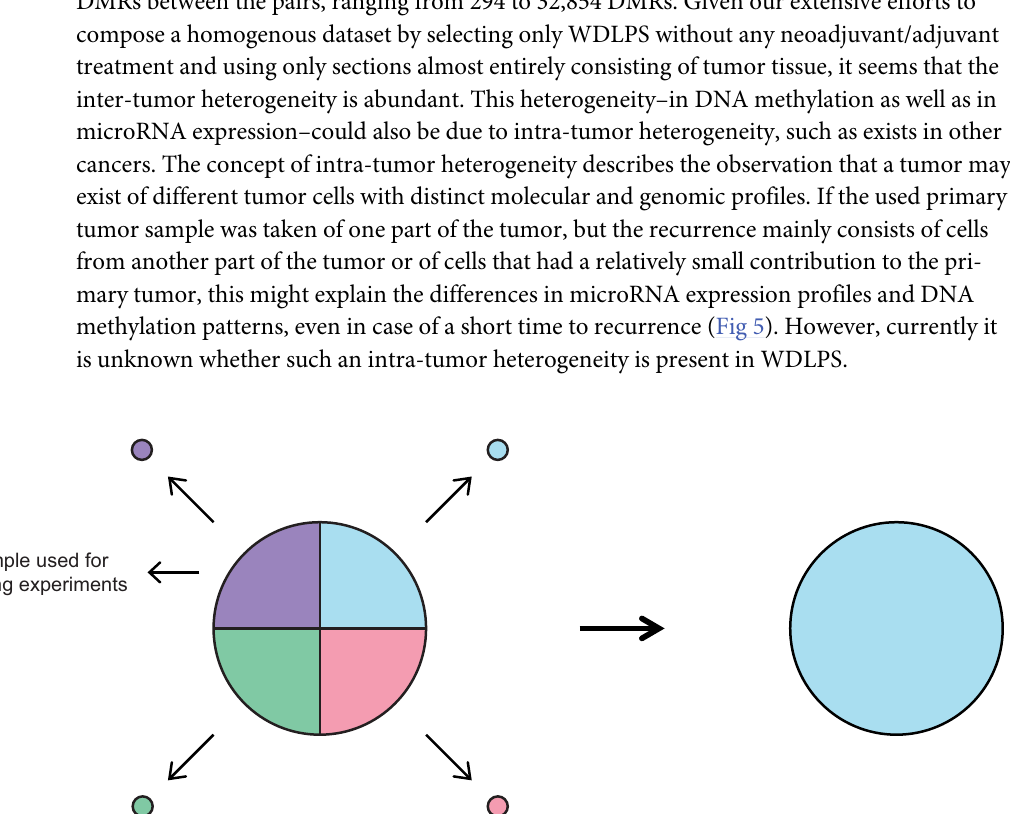
Fig 4. Hierarchical clustering based on differentially methylated DNA regions (DMRs) between paired WDLPS tumor samples for the two main localizations. ( A ) Results of the hierarchical supervised clustering, excluding sex chromosomal regions (N = 27), based on 604 DMRs of the 15 paired WDLPS samples localized in the extremity. ( B ) Results of the hierarchical supervised clustering analysis based on the 51 DMRs with a fold change � 2, excluding sex chromosomal regions (N = 2), of the 8 paired retroperitoneal WDLPS samples.